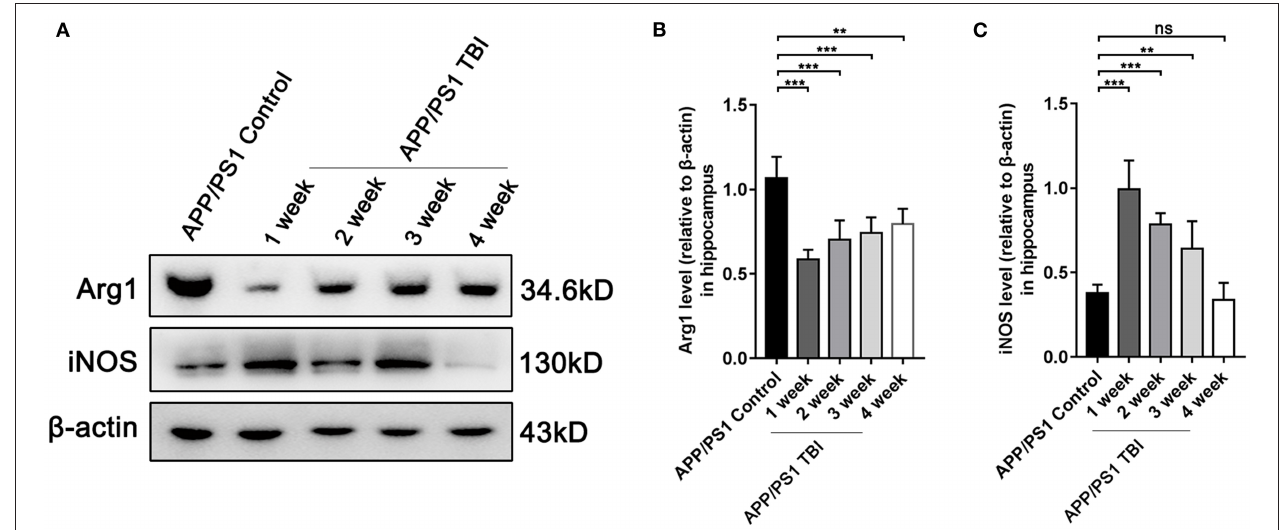
FIGURE 7 | TBI aggravated Alzheimer’s-like pathology by altering the phenotype of microglia. (A) Representative Western blotting images of Arg1, iNOS, and β -actin in the hippocampi of APP/PS1 and APP/PS1 TBI group mice. (B,C) Quantitative analyses of Arg1 (B) and iNOS (C) levels relative to β -actin expression in the hippocampi of APP/PS1 and APP/PS1 TBI group mice. The error bars represent SEM ( n = 8/group). ns, non-significant; ** p < 0.01; *** p <